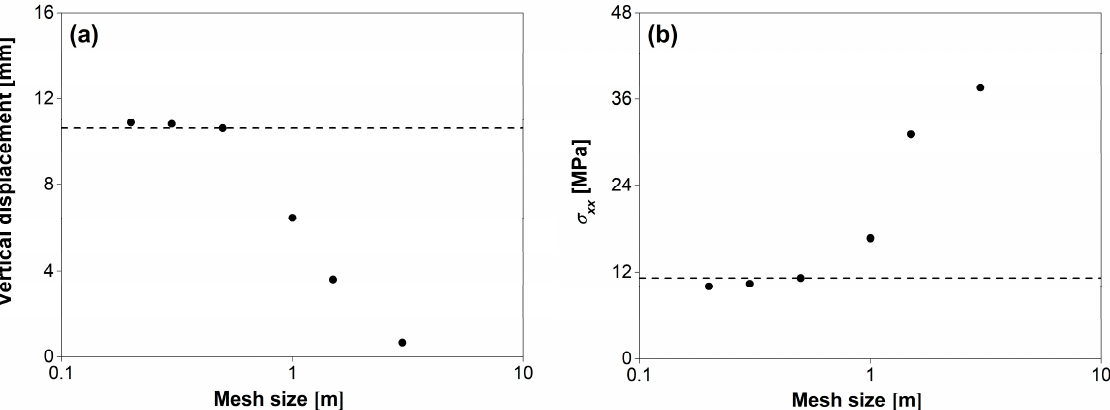
Figure 11. Variation of the ( a ) vertical displacement ( z ‐ direction) and ( b ) horizontal stress σ xx at point N (see Figures 9a and 10) as a function of the mesh size m (for d = 500 m).